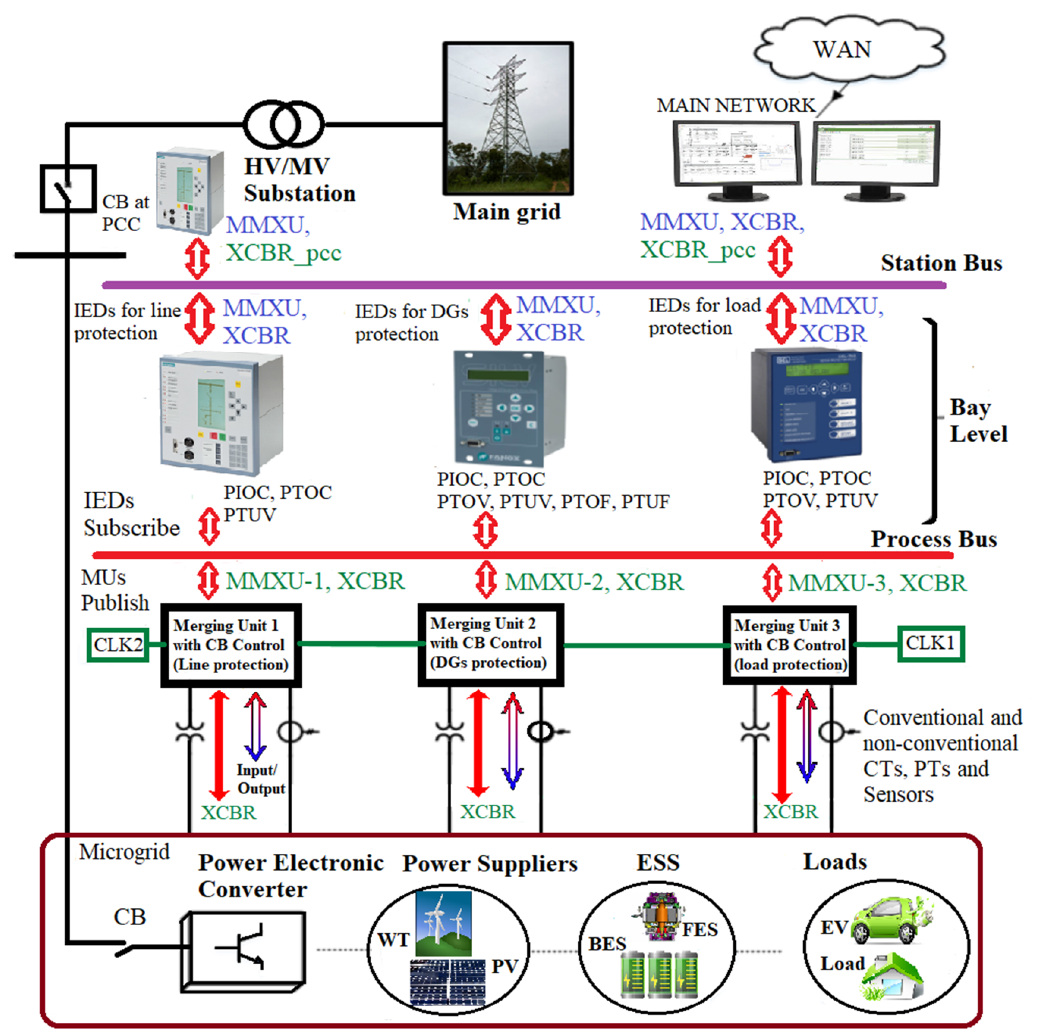
Figure 1. Adaptive AC microgrid protection based on the IEC 61850 communication standard. HV: High Voltage, WT: Wind Turbine, ESS: Energy Storage System, BES: Battery Energy Storage, FES: Flywheel Energy Storage, MMXU: Measurement, XCBR: Circuit Breaker, CT: Current Transformer, PT: Potential Transformer (VT: Voltage Transformer), CLK: Clock, PIOC: Instantaneous Overcurrent Protection, PTOC: AC Time Overcurrent Protection, PTOV: (Time) Overvoltage Protection, PTUV: (Time) Undervoltage Protection, PTOF: Overfrequency Protection, PTUF: Underfrequency Protection.